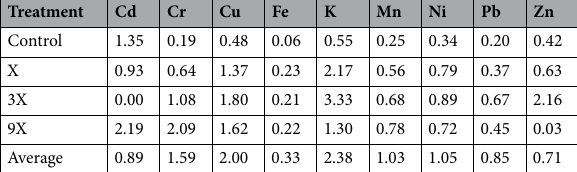
Table 9. Bioconcentration factor (BCF) in roots.